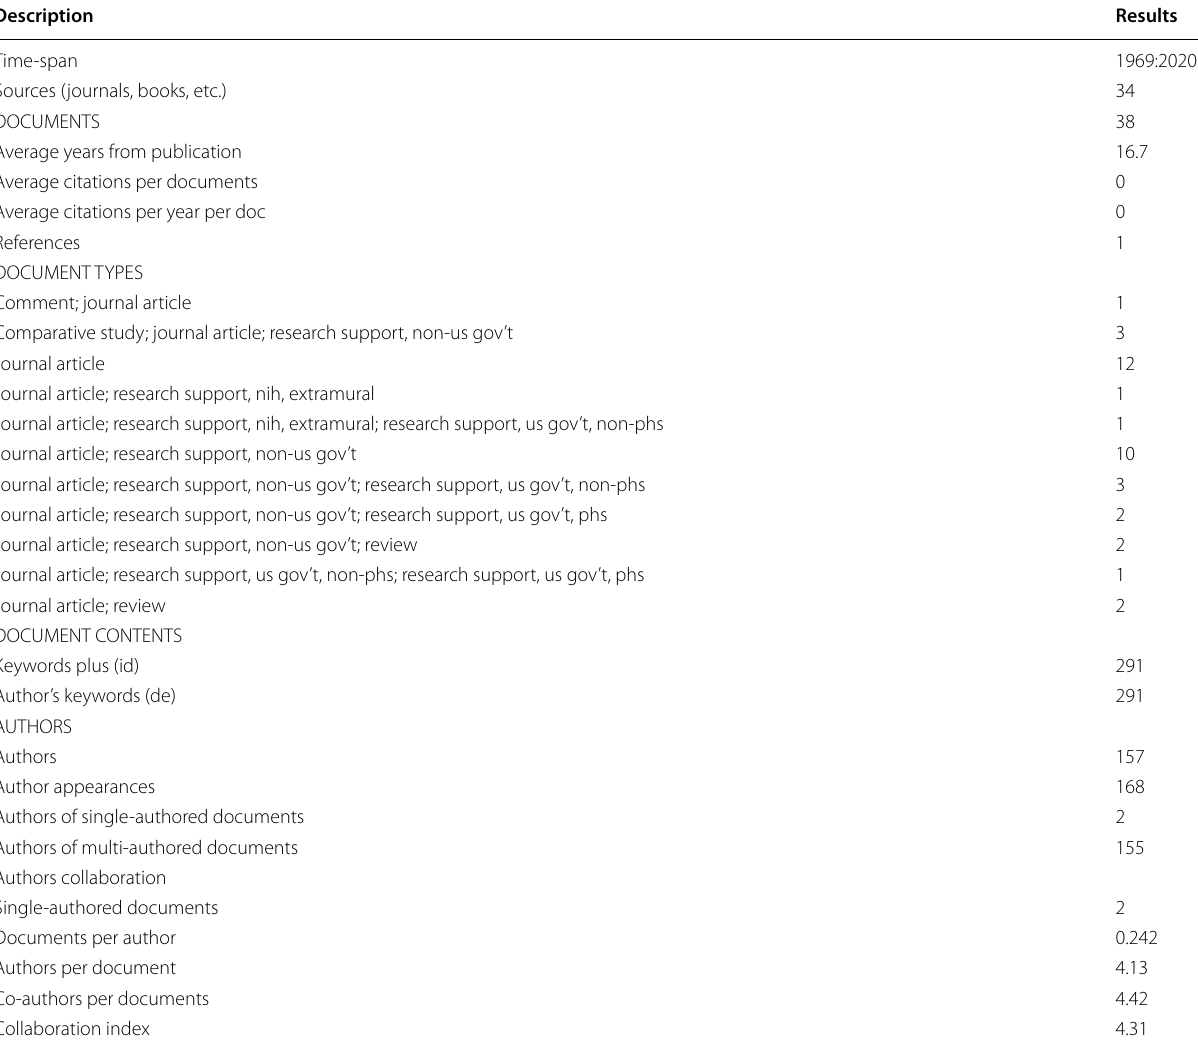
Table 1 Main information about the dataset on Wastewater AND Cell free nucleic acid OR extra-chromosomal